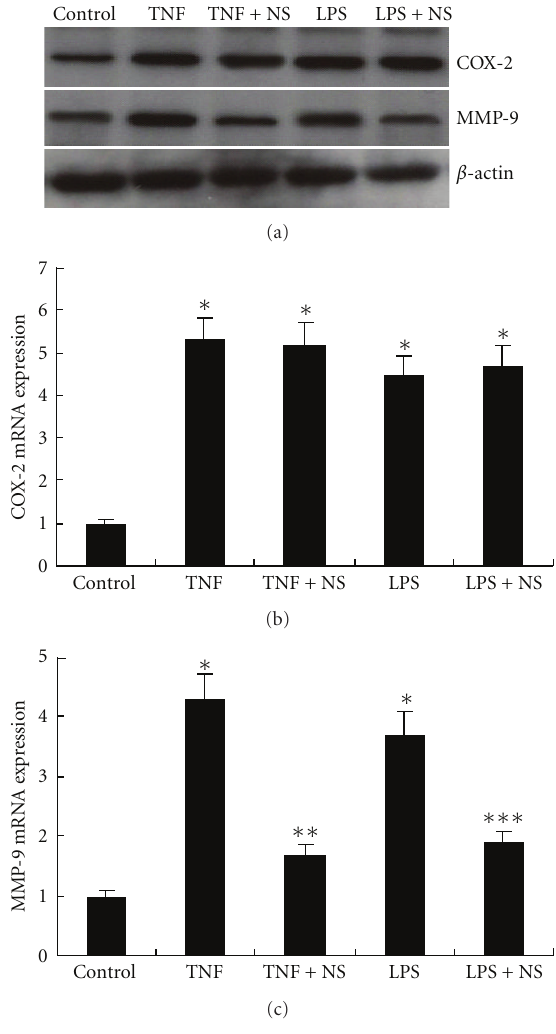
Figure 5: Involvement of COX-2 in the upregulation of MMP- 9 by TNF- α and LPS. (a) Western blotting revealed expression of COX-2 and MMP-9 was increased in BxPC-3 after treatment with exogenous TNF- α or LPS. (b) COX-2 mRNA expression was upregulated by TNF- α or LPS ( ∗ P < 0 . 01, resp., versus control). NS398 had no e ff ect on the upregulation. (c) MMP-9 mRNA expression was upregulated by TNF- α or LPS ( ∗ P < 0 . 01, resp., versus control). The upregulation was significantly inhibited by NS398. Data are expressed as mean ± SD, n = 3. NS: